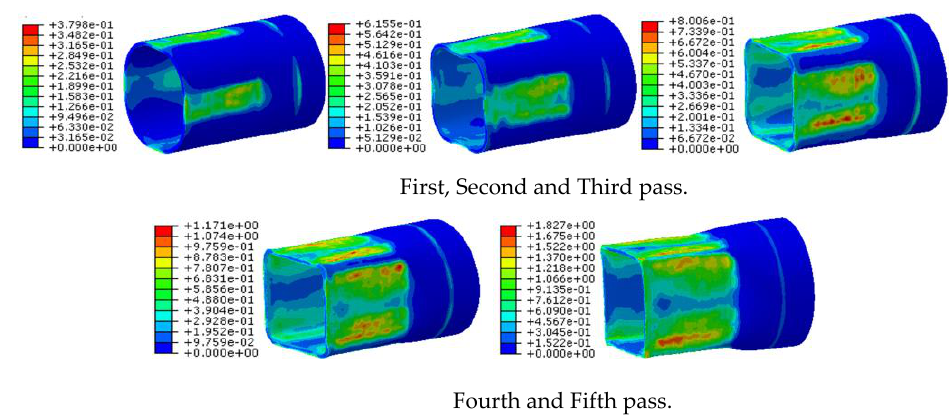
Figure 7. Equivalent strain in the workpiece for each pass of the non-circular spinning process.